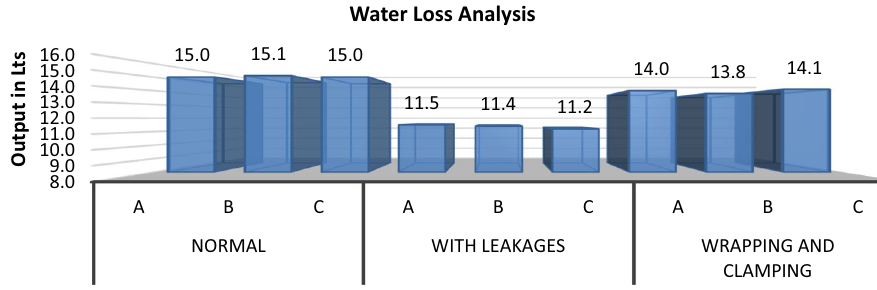
Fig. 7 Graphical representation of output of water at different conditions